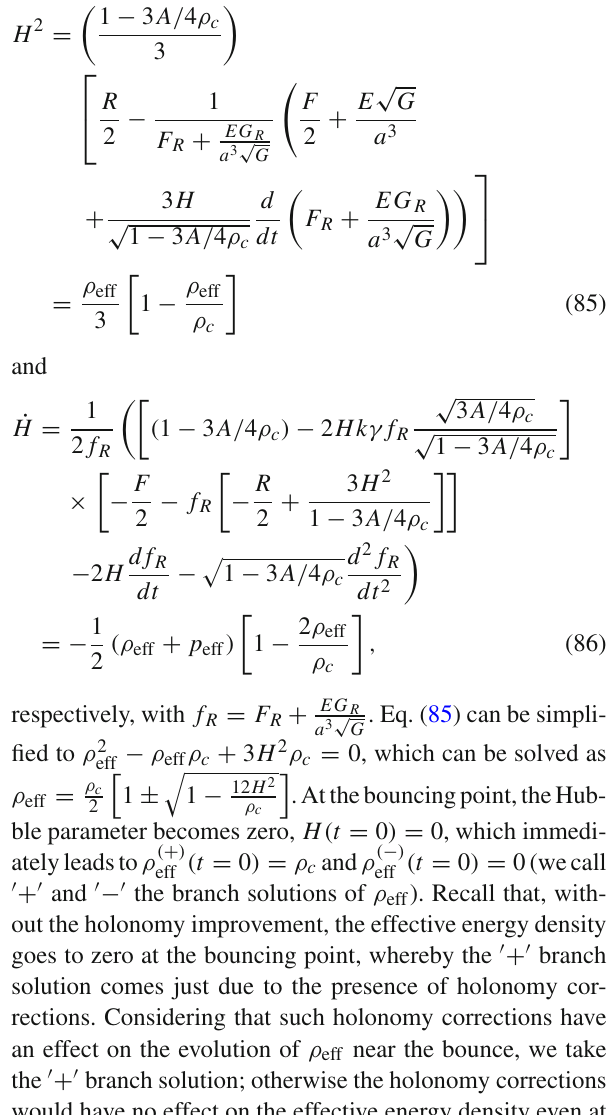
Fig. 2 Parametric plot of α vs n for R h